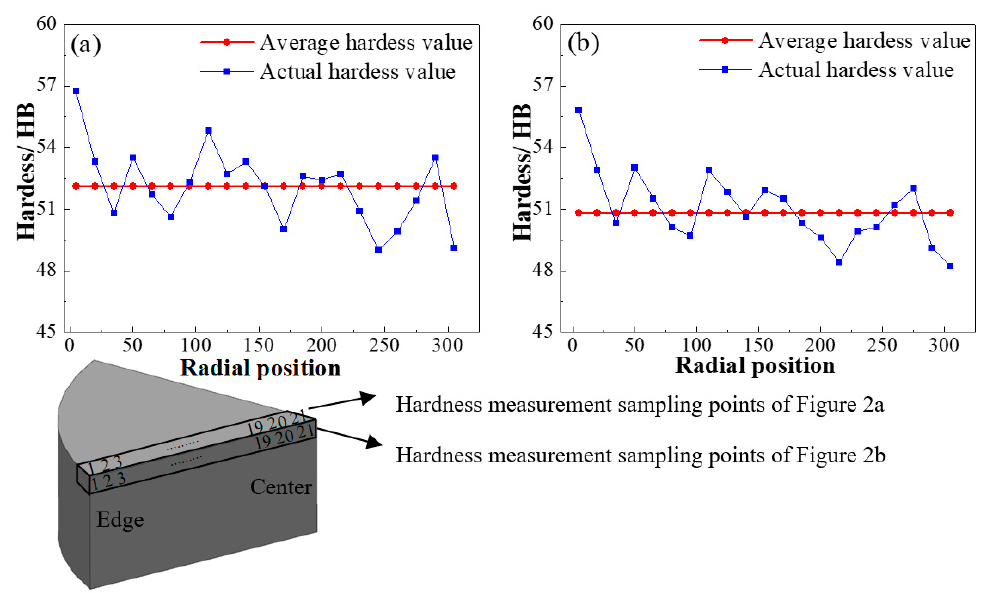
Figure 3. Hardness values in the different sampling points along the radial direction. ( a ) hardness value in the cross-section; ( b ) hardness value in the longitudinal section.